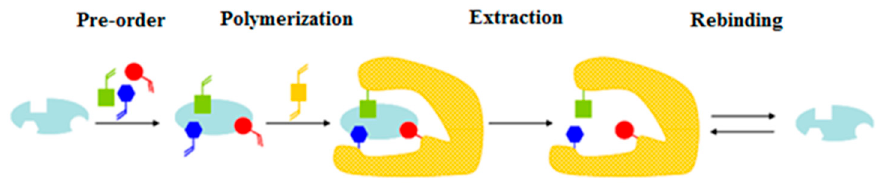
Figure 3. Schematic representation of the noncovalent imprinting approach.